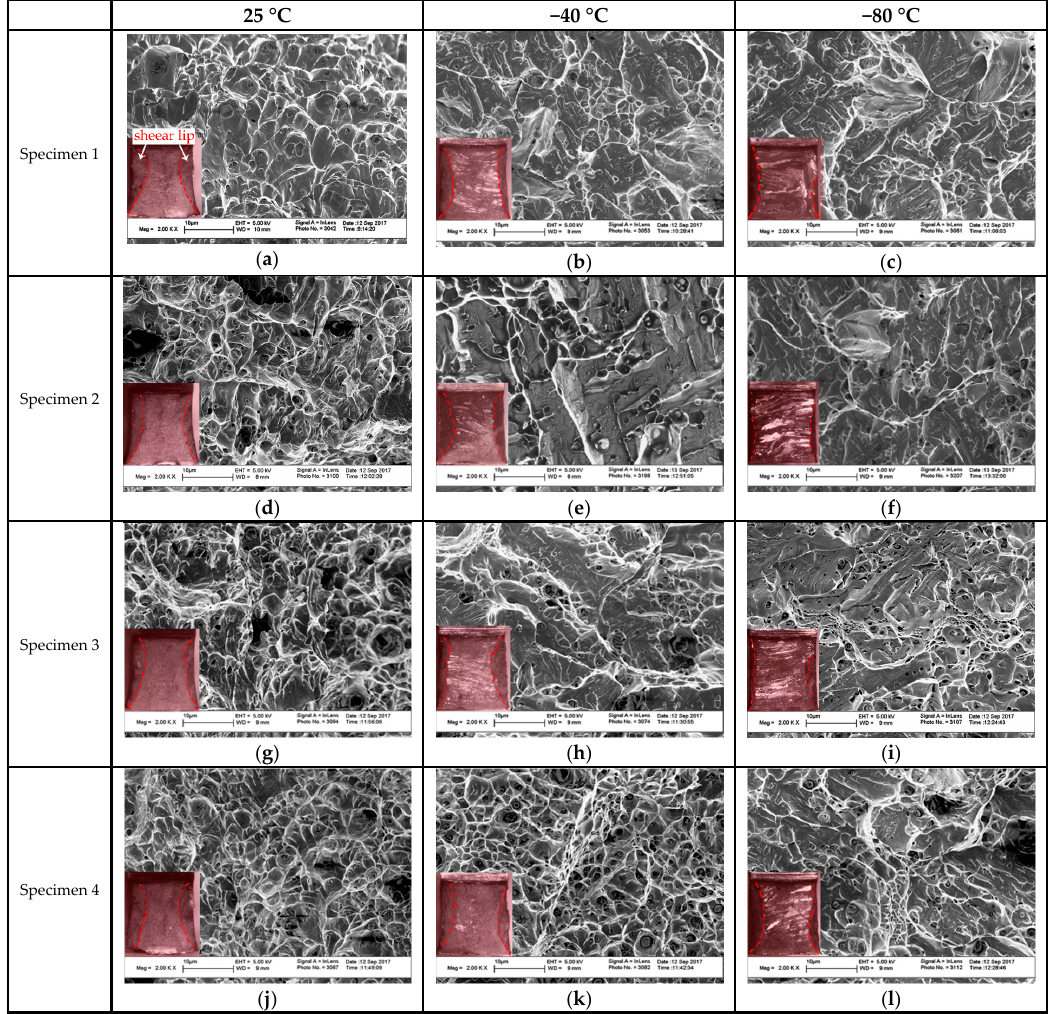
Figure 15. SEM fracture surfaces of weld metals after impact test: ( a – c ) of Specimen 1; ( d – f ) of Specimen 2; ( g – i ) of Specimen 3 and ( j – l ) of Specimen 4.